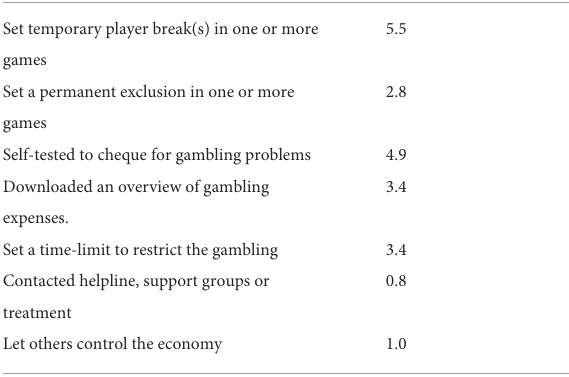
TABLE 2 Percentage (including 95% confidence interval) for the eight items measuring self-regulation and help seeking for gambling problems ( N =